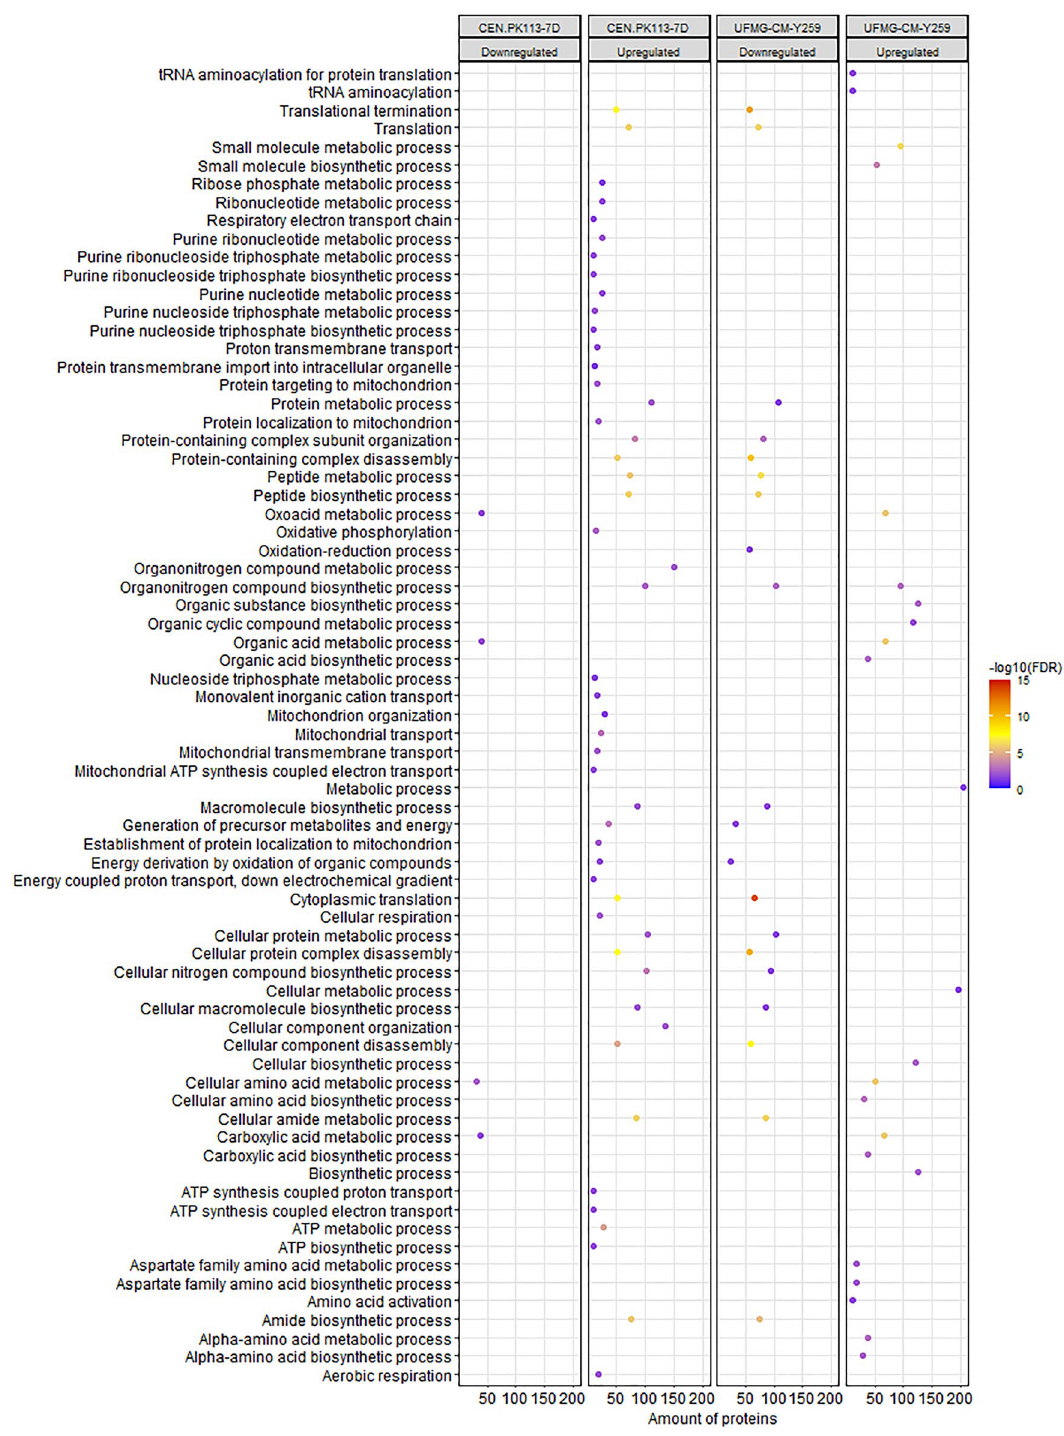
Figure 2. GO biological process overrepresentation analysis for differentially expressed proteins for Saccharomyces cerevisiae strains CEN.PK113-7D and UFMG-CM-Y259 cultivated on sucrose compared to glucose grown cells. For JP1 no significant enrichments were detected. The number of proteins in the dataset that falls in each overrepresented biological process is shown on the x-axis (amount of